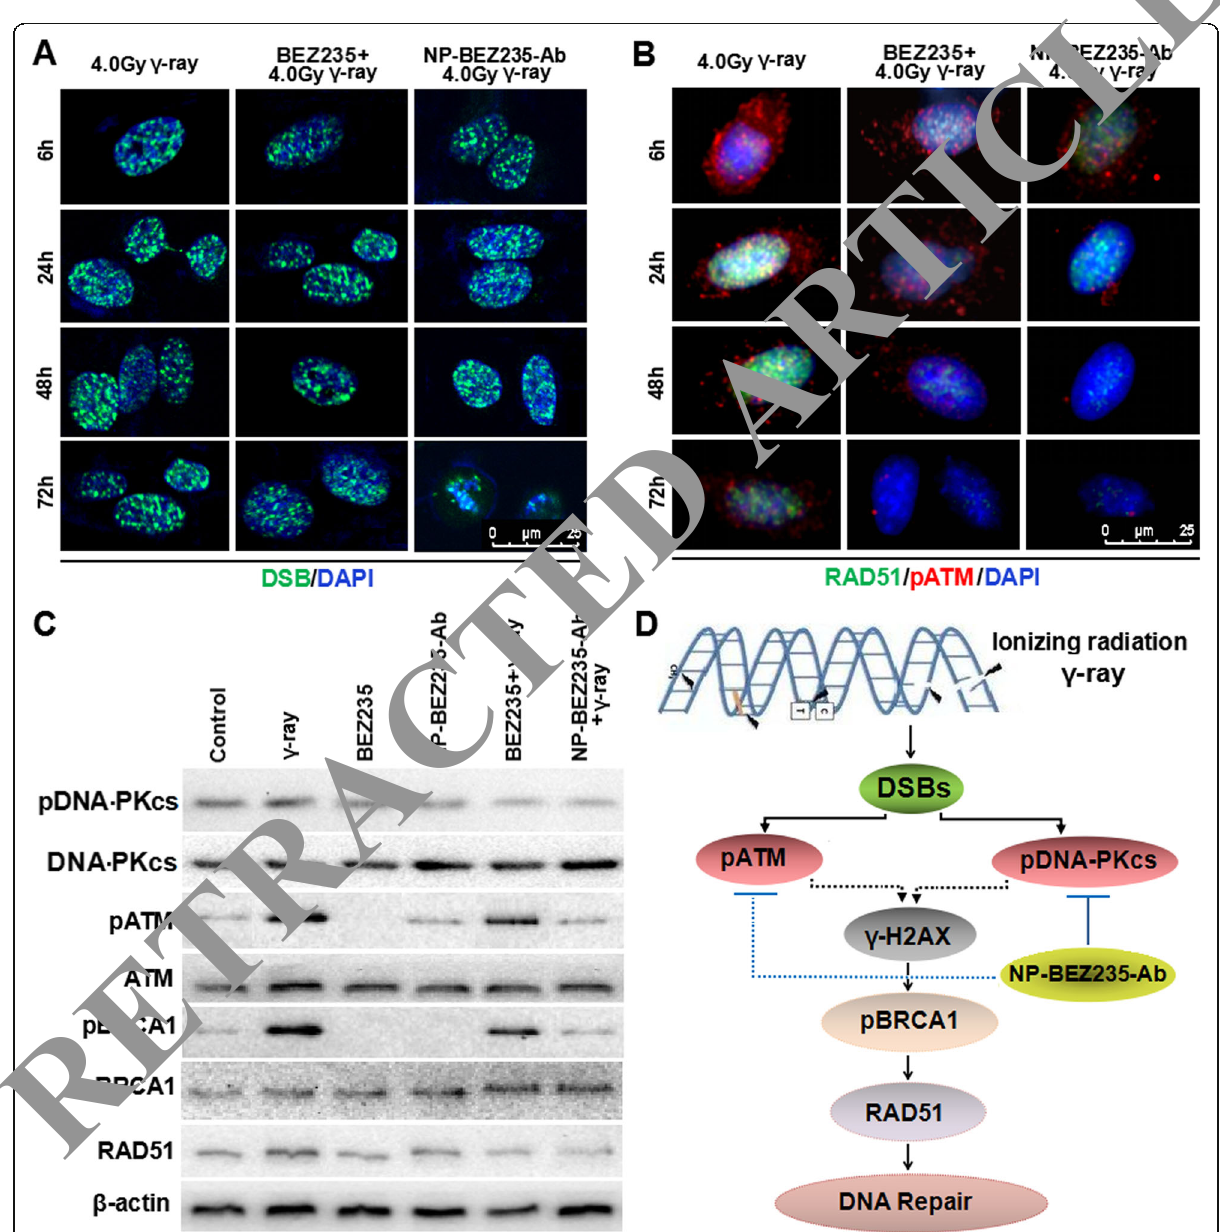
Fig. 6 Effect and mechanism of NP-BEZ235-Ab enhancing radiosensitivity. a After 4.0 Gy γ -ray irradiation, the γ H2AX focus level in the nucleus increased significantly within 24 h and did not decrease significantly through 72 h. However, in the NP-BEZ235-Ab group combined with 4.0 Gy for 48 h, the nucleus began to condense; after 72 h, there was obvious nuclear pyknosis of cells treated with NP-BEZ235-Ab and radiation. b Expression of RAD51 and pATM in cells of different groups. c Expression levels of pBRCA1, RAD51, and pATM in different groups. d Schematic diagram of the mechanism of NP-BEZ235-Ab enhancing